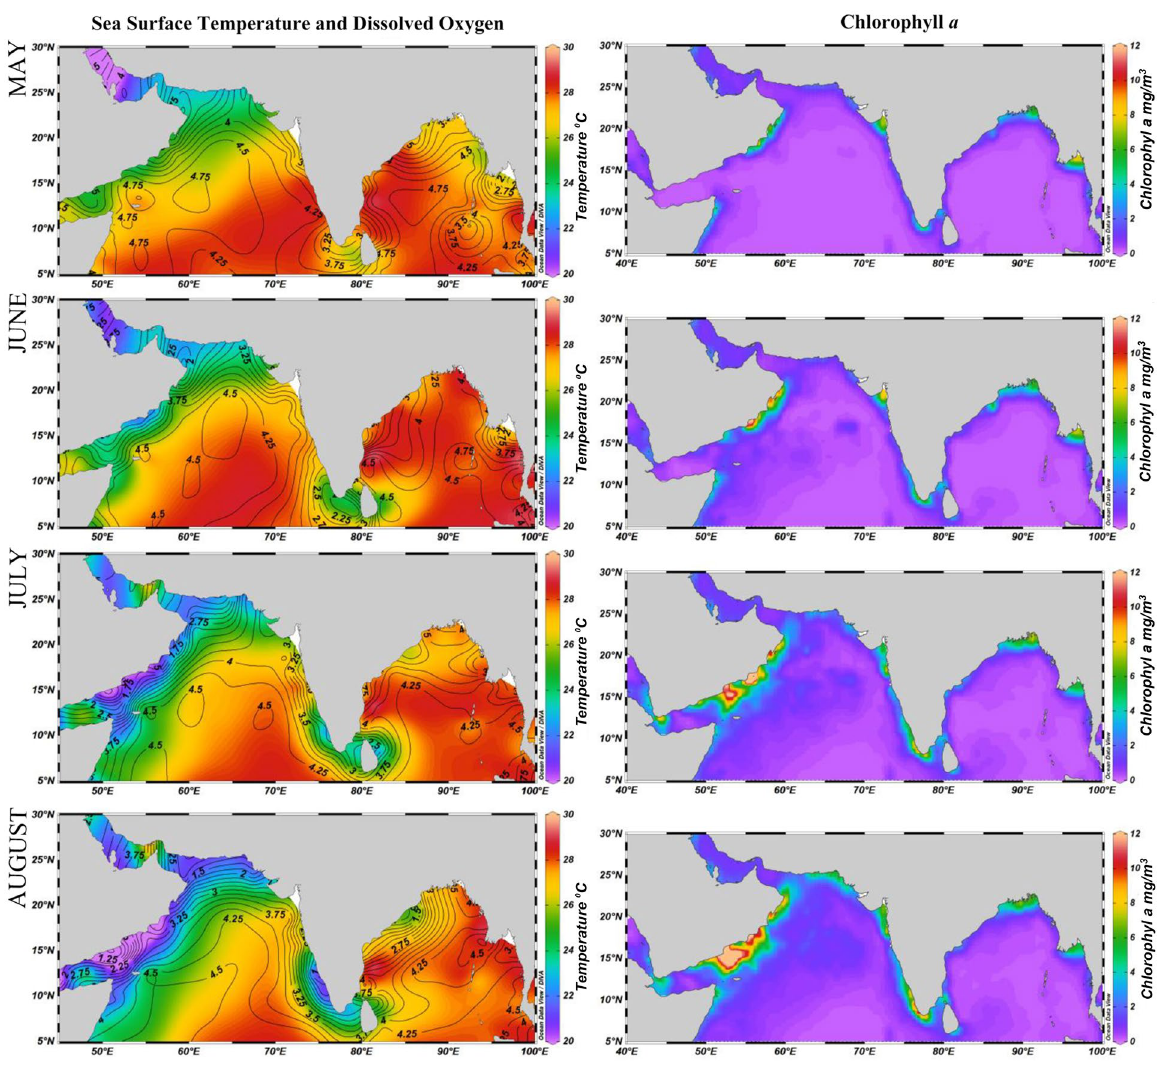
Figure 3. Monthly Chlorophyll- a (mg/m 3 ), sea surface temperature (°C) and dissolved oxygen (µmol/kg) for the Bay of Bengal and the Arabian Sea from May to August. Chlorophyll- a and sea surface temperature gradients are represented as coloured shades. Dissolved oxygen is represented as contour lines. The images were generated in ODV 5.1.7 (https:// odv. awi.